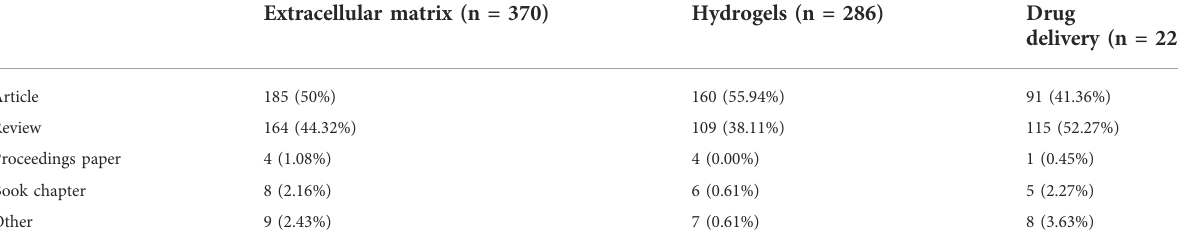
TABLE 1 Publication types of selected